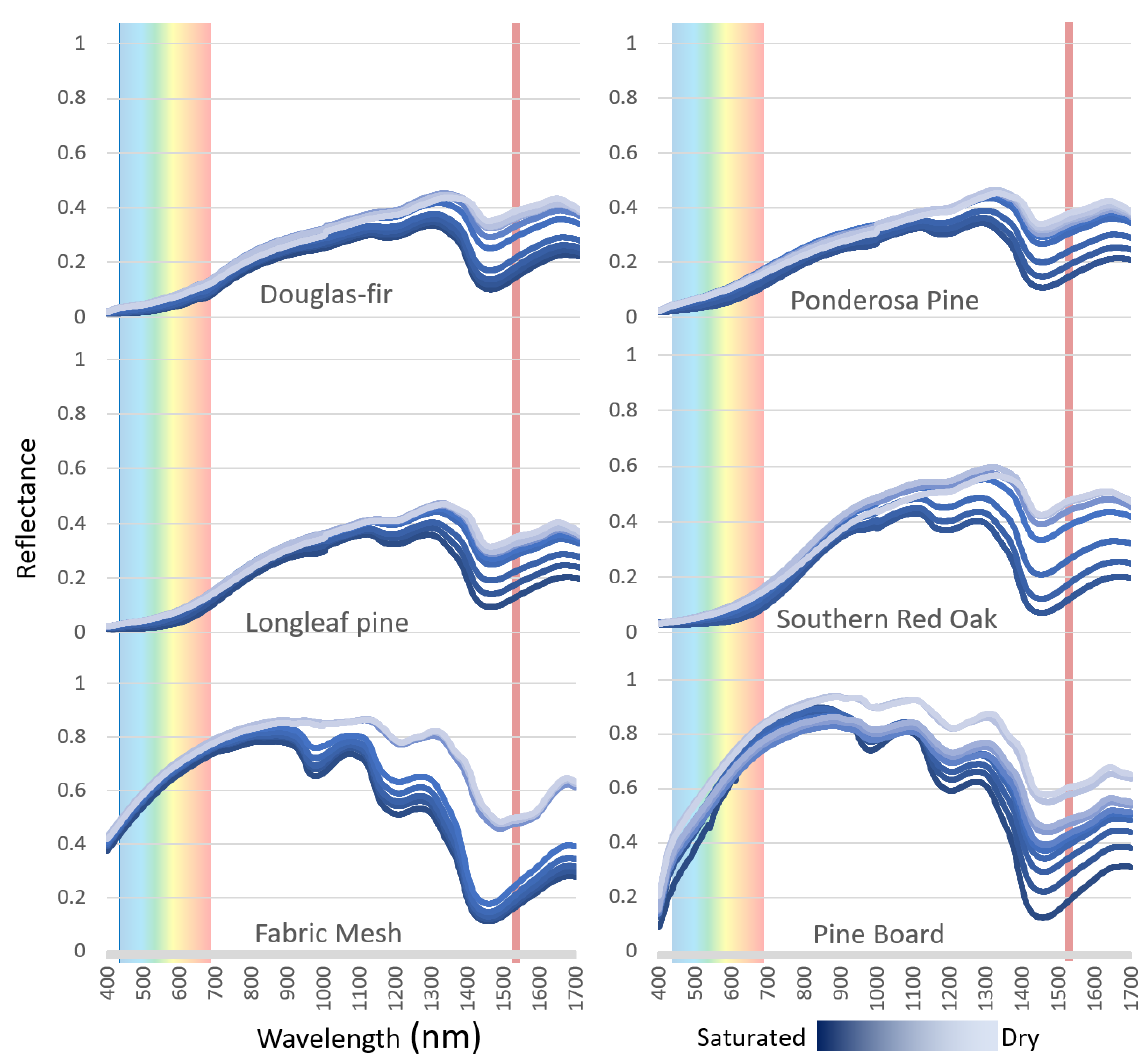
Figure 5. Average reflectance values by sample material and saturation level. The dark blue line represents samples at full saturation, with the color lightening to light blue for the final oven-dried reflectance values. The red line at 1550 nm represents the wavelength of the TLS units used for this experiment.